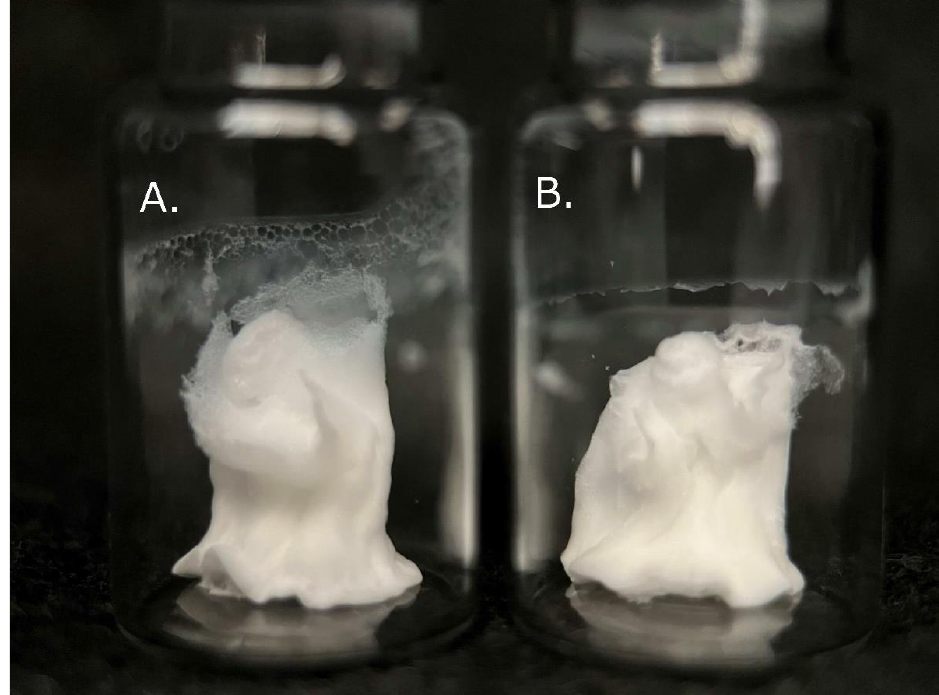
Figure 3. Appearance of lyophilized human serum albumin (HSA)-based solutions with ( A ) and without ( B ) bubbling.